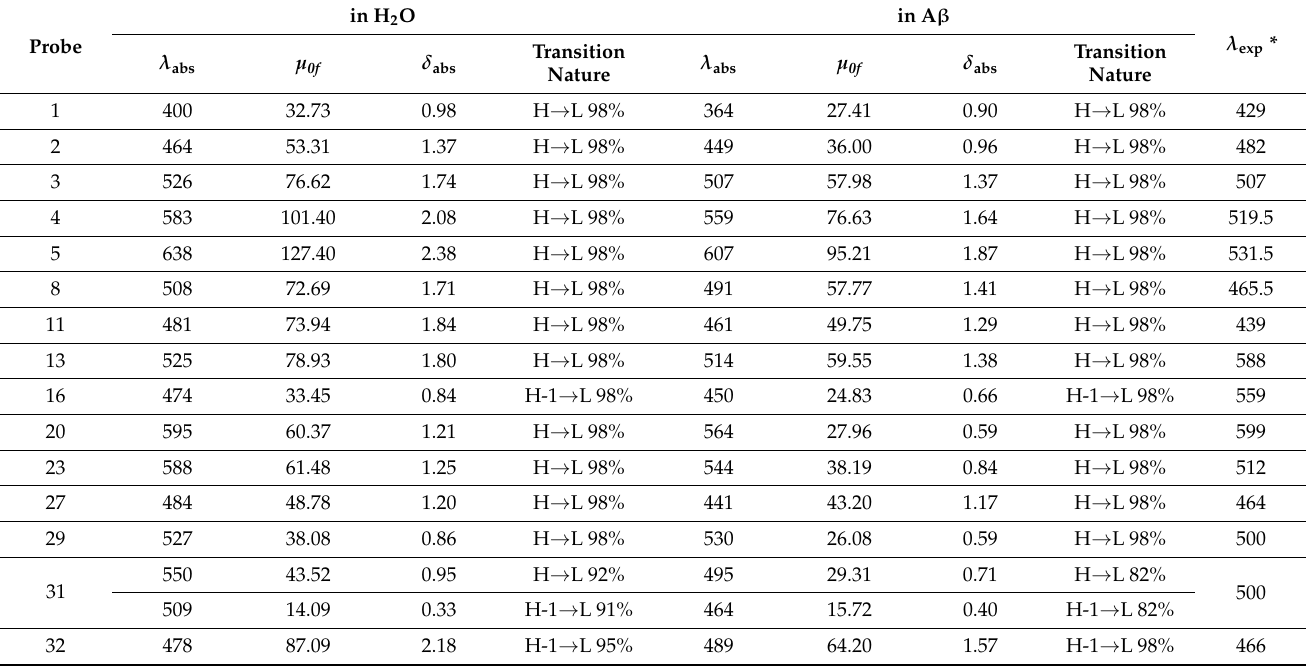
Table 1. Absorption maximum λ abs (nm), transition dipole moment µ 0f (Debye), oscillator strength δ abs (a.u.), and the transition nature of selected probes in H 2 O and in A β